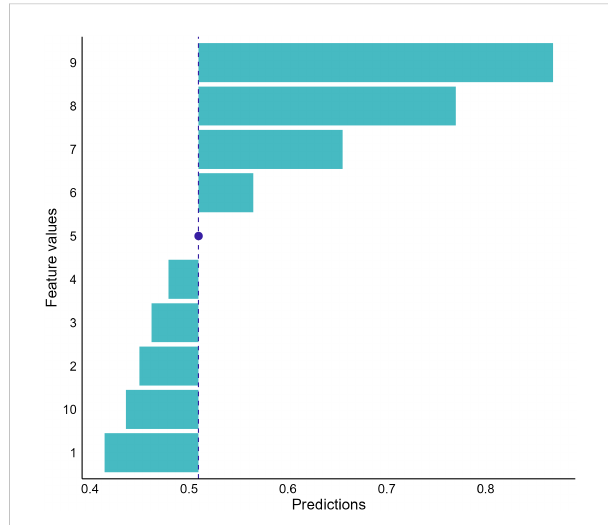
FIGURE 9 Conditional dependence between cell shape and the neural network prediction for our random-selected breast mass sample. The graph indicates that the cancerous probabilities increase if the sample ’ s cell shape score increases. The blue dot represents the observed score of cell shape for the sample we selected and the corresponding model